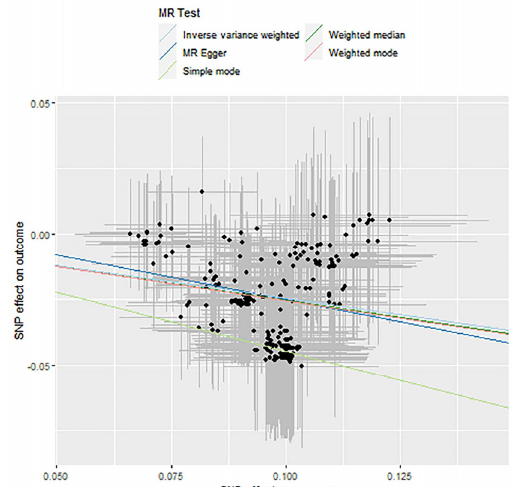
Figure 6. Causality analysis of Actinobacteria and blood lipid levels based on Mendelian randomi- zation. The x -axis represents the effect value associated with SNP and Actinobacteria , and the y -axis represents the effect value associated with SNP and LDL and levels in the blood.